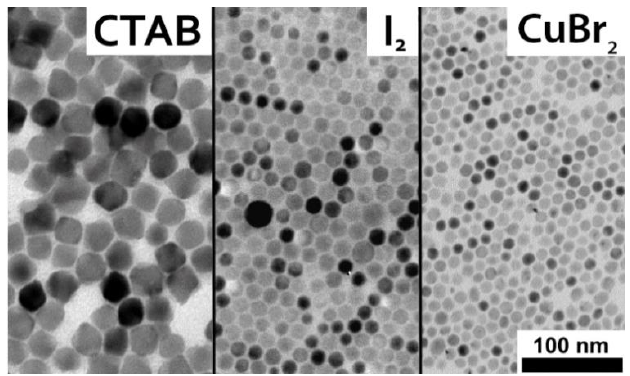
Figure 3. TEM micrographs of CsBr and CsI nanocrystals synthesized using cetyltrimethylammonium bromide (CTAB), I 2 , and CuBr 2 , respectively.